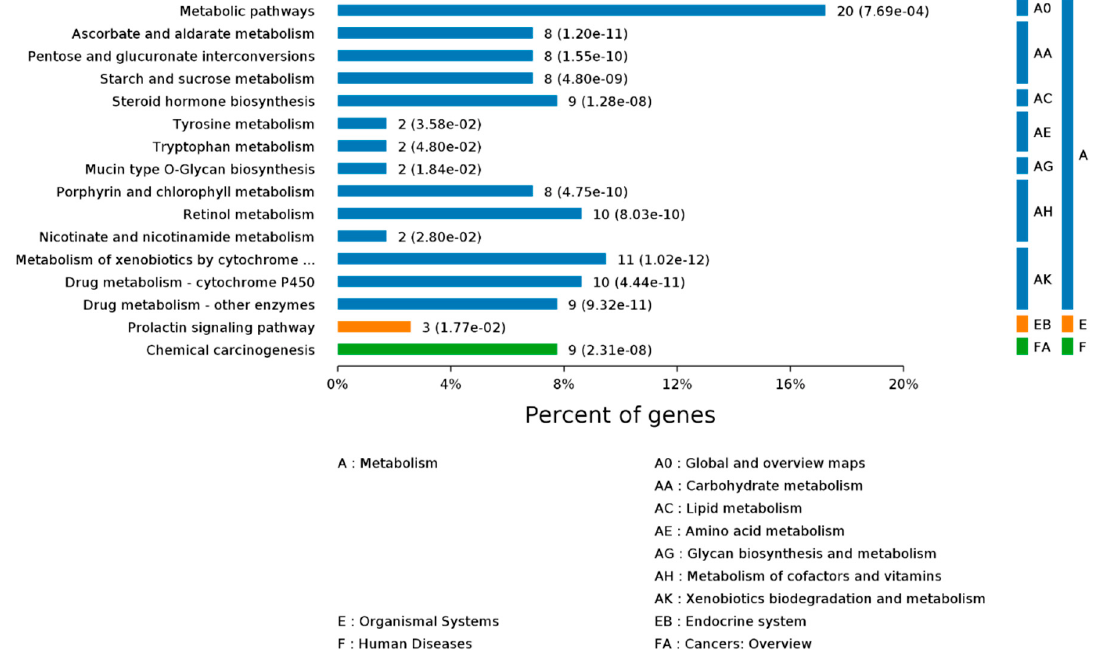
Figure 2. KEGG Pathway names for DEGs. Based on the KEGG biology pathway database (http://www.genome.jp/) from the perspective of complex regulatory networks, the differential gene sets were enriched, thus the most relevant biological pathways on the differentially expressed gene were extracted. Table 2. 20 genes upregulated in Se-Met-treated 3 × Tg-AD mice versus 3 × Tg-AD